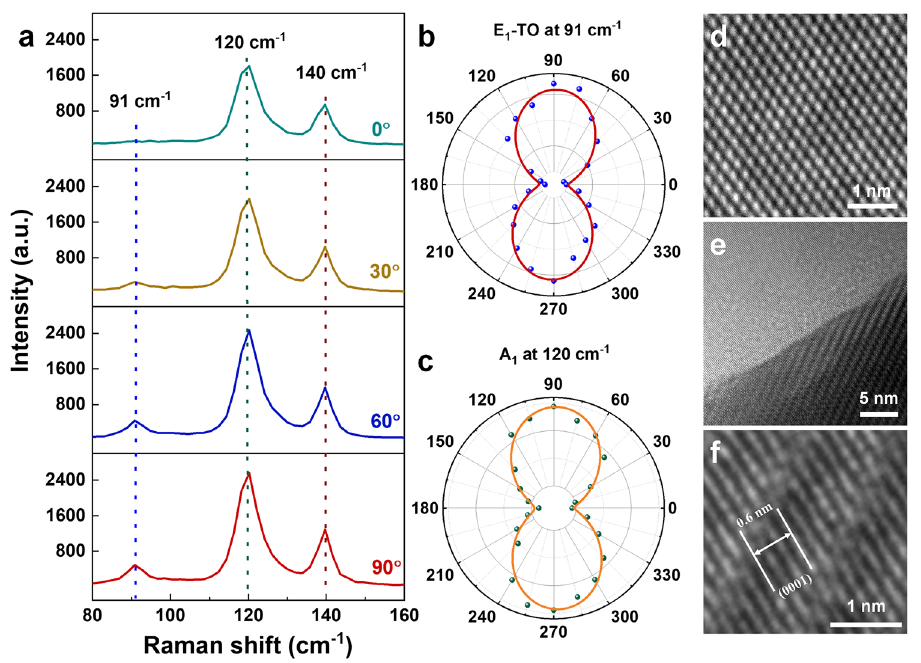
Fig. 2 a Angle‑resolved Raman spectra of a Te nanobelt with thickness of 30 nm with angles between the crystal orientation and incident laser polarization. b, c Polar figures of Raman intensity corresponding to E 1 ‑TO mode located at 91 cm −1 ( b ) and A 1 mode located at 120 cm −1 ( c ). d–f HRTEM images of Te nanobelts grown on h‑BN; d bare h‑BN, e edge of Te nanobelt on h‑BN, f a zoomed‑in area of Te nanobelt grown on h‑BN from